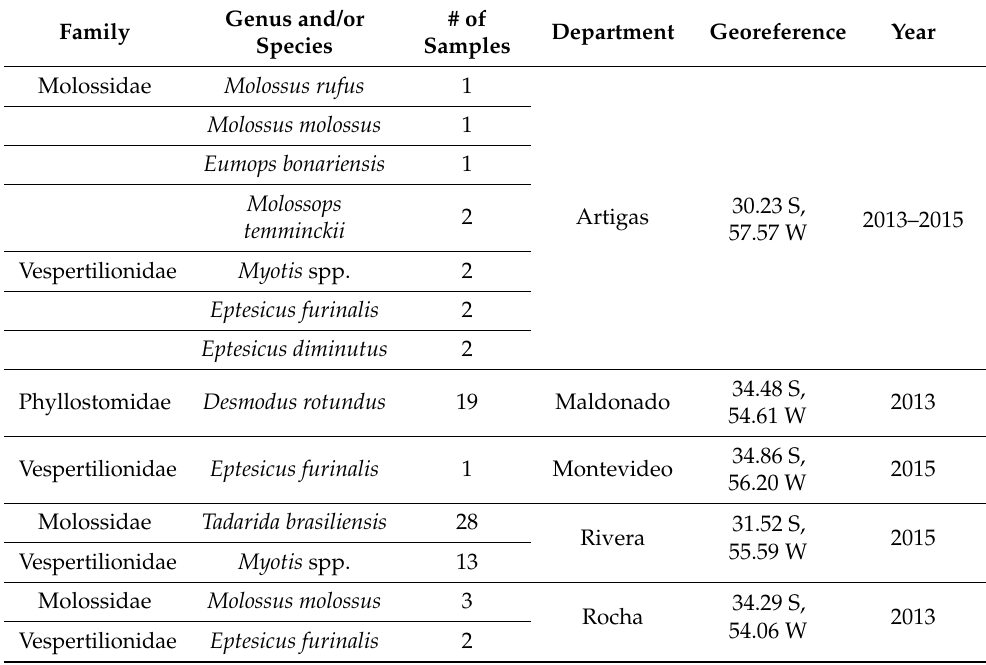
Table 1. Georeferenced locality, year, and number of bat families and species sampled. Genus and/or # of Department Family Species Samples